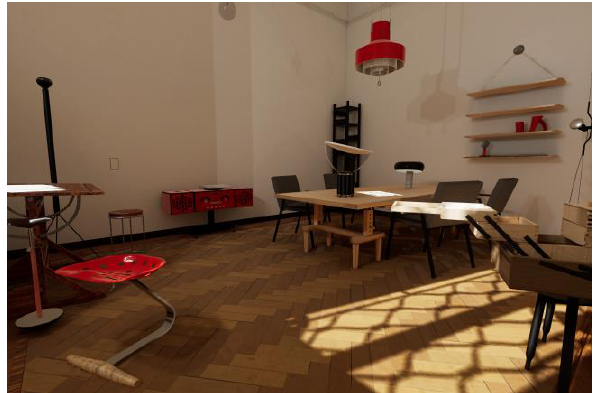
Figure 6. Virtual simulation: view of the Meeting Room.